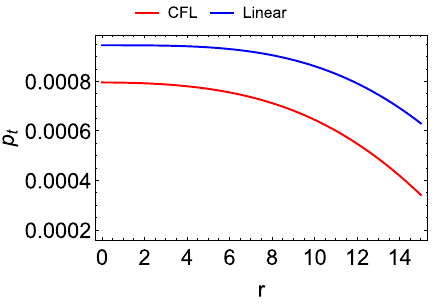
Fig. 3 Variation of tangential pressure with radial coordinate outwards towards the boundary. In addition, the linear